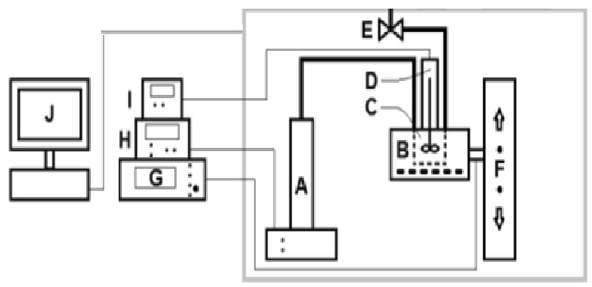
Fig. 1 Schematic of subcritical water processing set-up for cracking heavy hydrocarbons. A Isco 500D syringe pump; B Premex electric heating mantle; C Hastelloy C Premex autoclave; D Premex magnetic stirrer; E back pressure regulator; F Premex lift; G Premex controller; H Isco D-series pump controller; I all control temperature controller; J